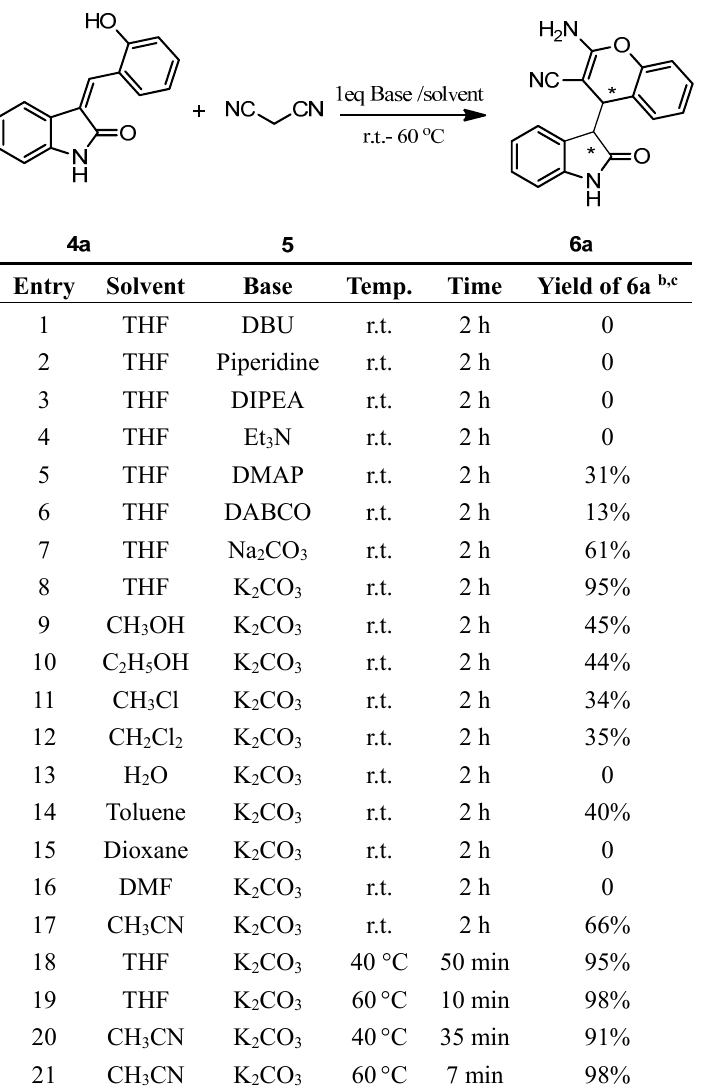
Table 1. Optimization for the synthesis of 2-amino-4-(2-oxoindolin-3-yl)-4 H -chromene 6a a